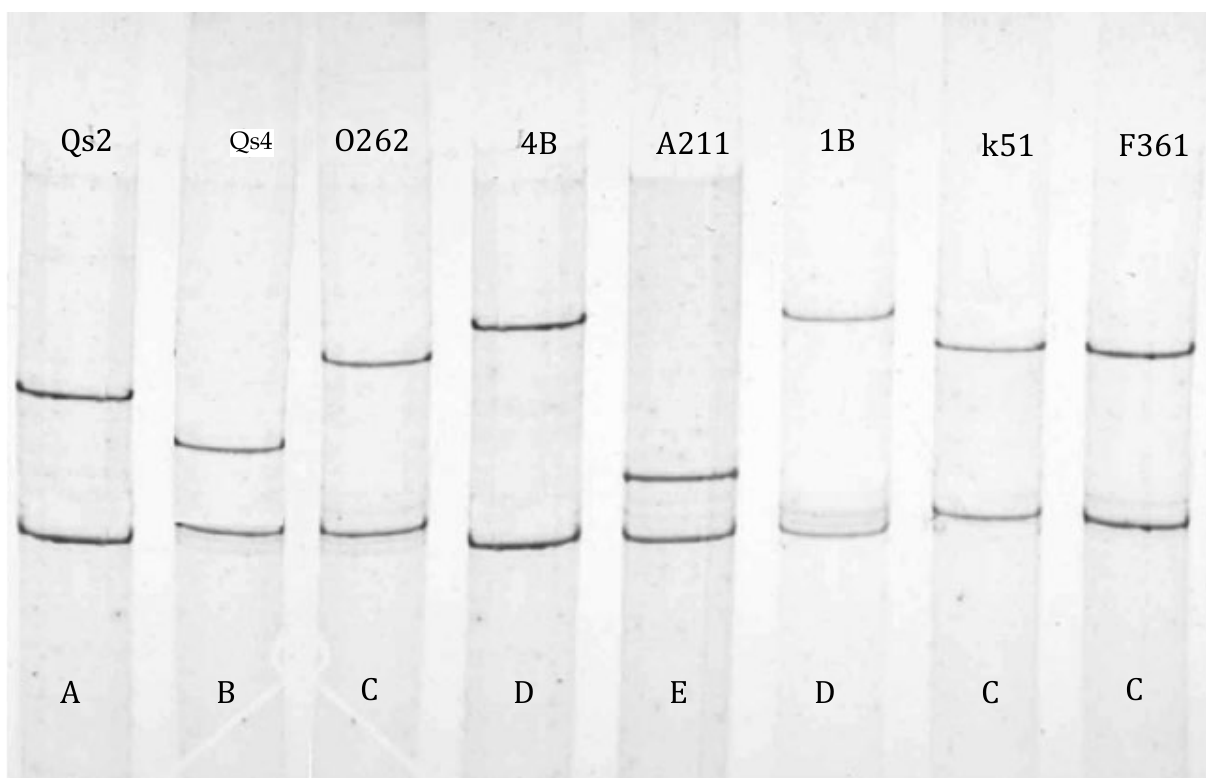
Figure 1. Electrophoretic SSCP patterns of the CP gene RT-PCR amplicons from isolates of Citrus tristeza virus . Isolates from left to right: Qs2, Qs4 (from Syria), and O262, 4B, A211, 1B, k51, F361 (from Apulia). Isolates with similar pattern are indicated with the same letter of the